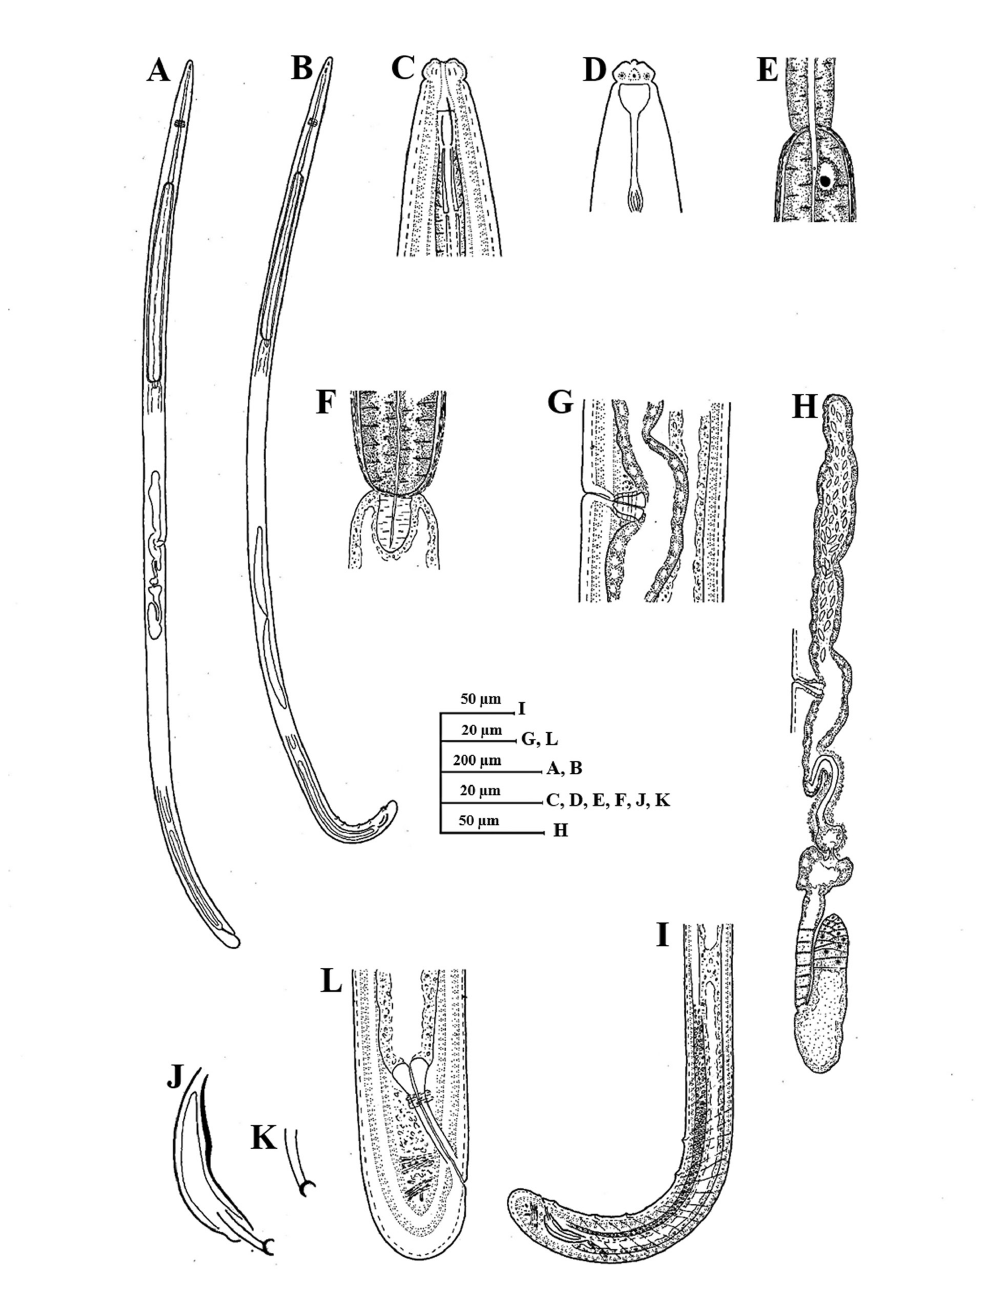
Fig. 13. Axonchium tropicum sp. nov. A , D – H , L . Holotype, ♀ (AMU/ZD/ Axonchium tropicum sp. nov. /1). B , I – K . Paratype 1, ♂ (slide 2). C . Paratype 2, ♀ (slide 2). A . Entire female. B . Entire male. C . Anterior region. D . Anterior end showing amphid. E . Junction between anterior slender and posterior expanded part of pharynx. F . Cardia. G . Vulva. H . Female genital system. I . Male posterior region. J . Spicule. K . Lateral guiding pieces. L . Female